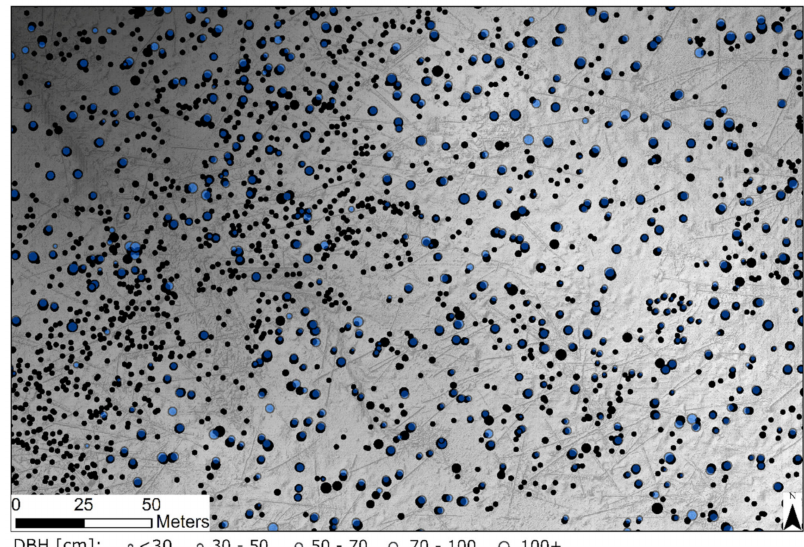
Figure A2. Small section of the ZFDP stem position map demonstrating correspondence between locations of segmented trees and field-mapped stems. Black points are stem positions from field measurements. Blue points are stem positions from a supervised segmentation of high-density drone lidar. Note: Small positional mismatch is caused by uncertainty in field measurements. The background is a high-resolution digital terrain model from drone